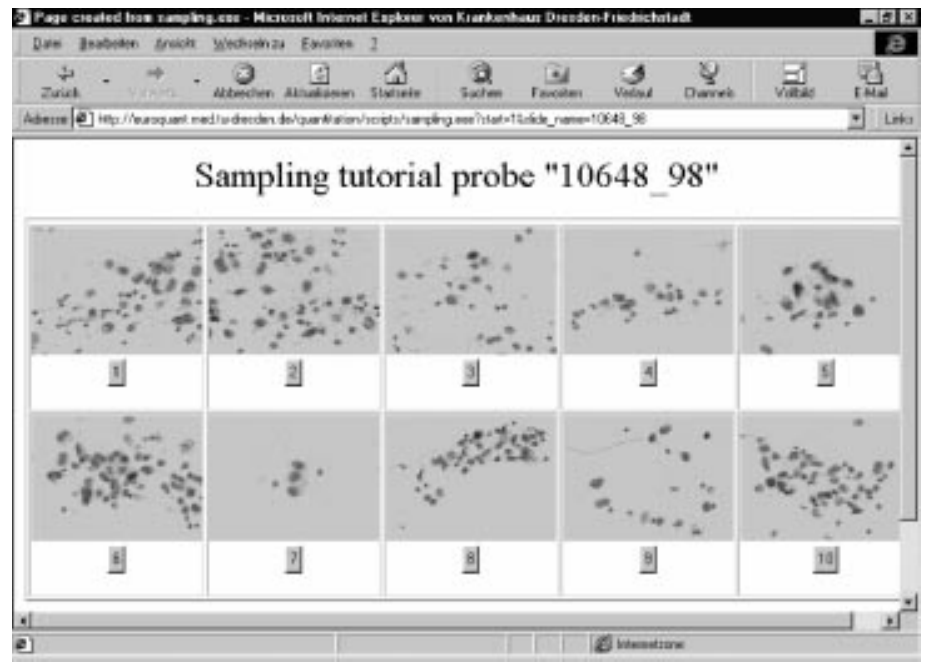
Fig. 6. Image gallery of scenes from a Feulgen stained tumor imprint. The user may select scenes and individual cells for performing a server based DNA